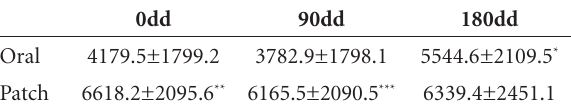
Table 4. Evaluation of BuChE levels at three time points (values in